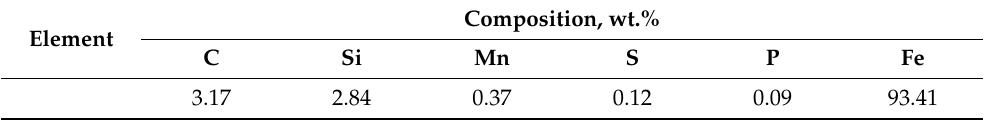
Table 1. Chemical composition of cast iron specimens used. Composition, wt.% Element C Si Mn S